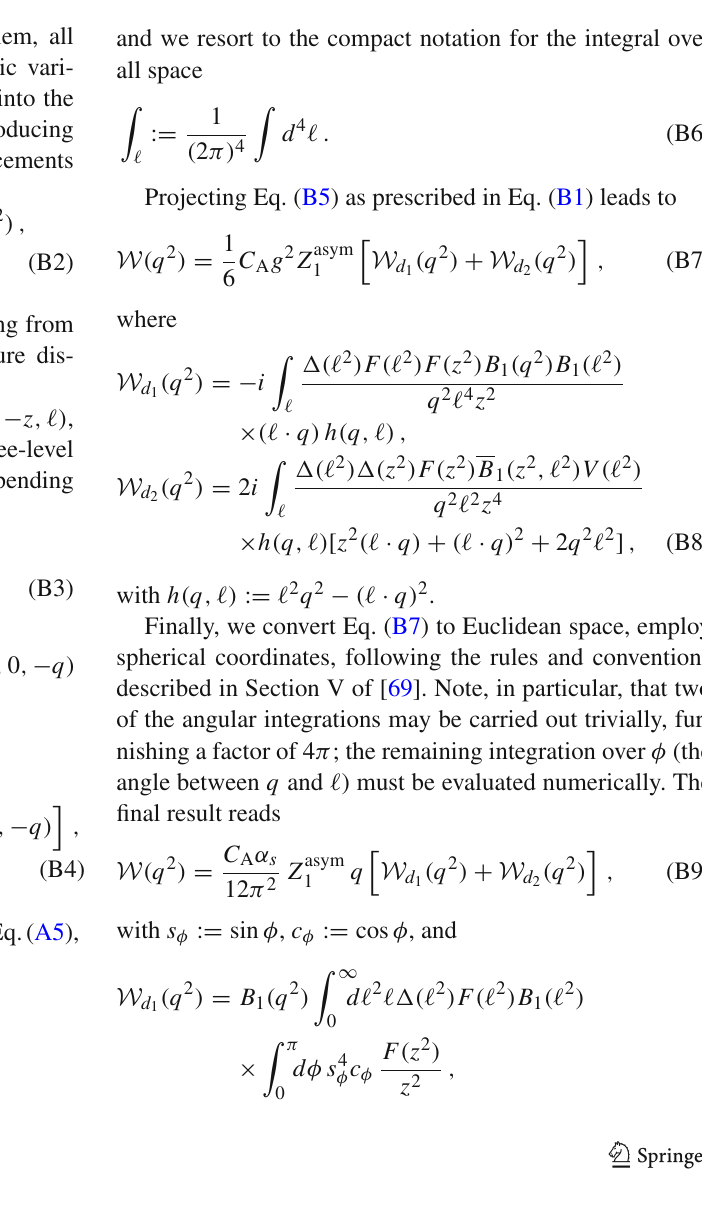
The implementation of Eq. (2.3) at the level of the three ghost-gluon vertices entering in the two diagrams of Fig. 7 reveals that only the form factors B 1 survive the projection to W ( q 2 )